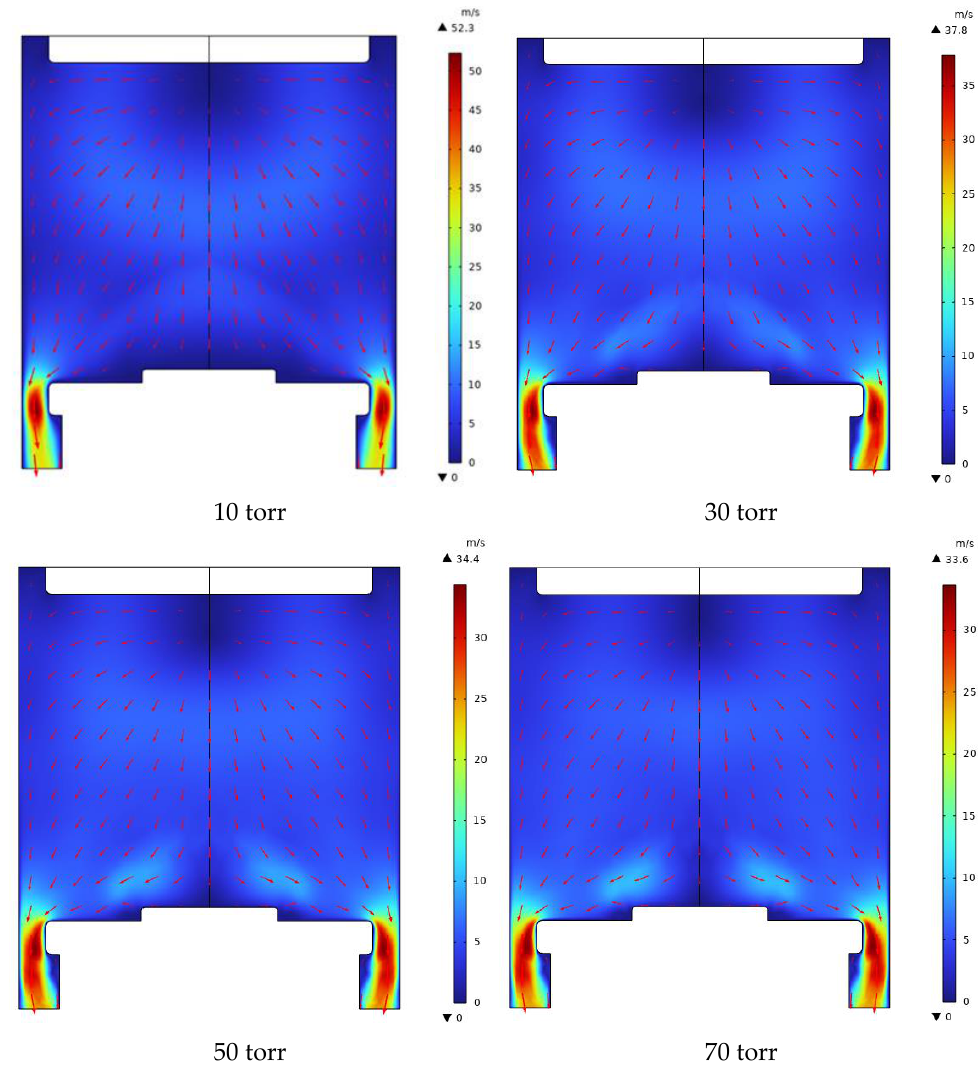
Figure 9. Contour plots of velocity distribution in the deposition chamber (m/s).